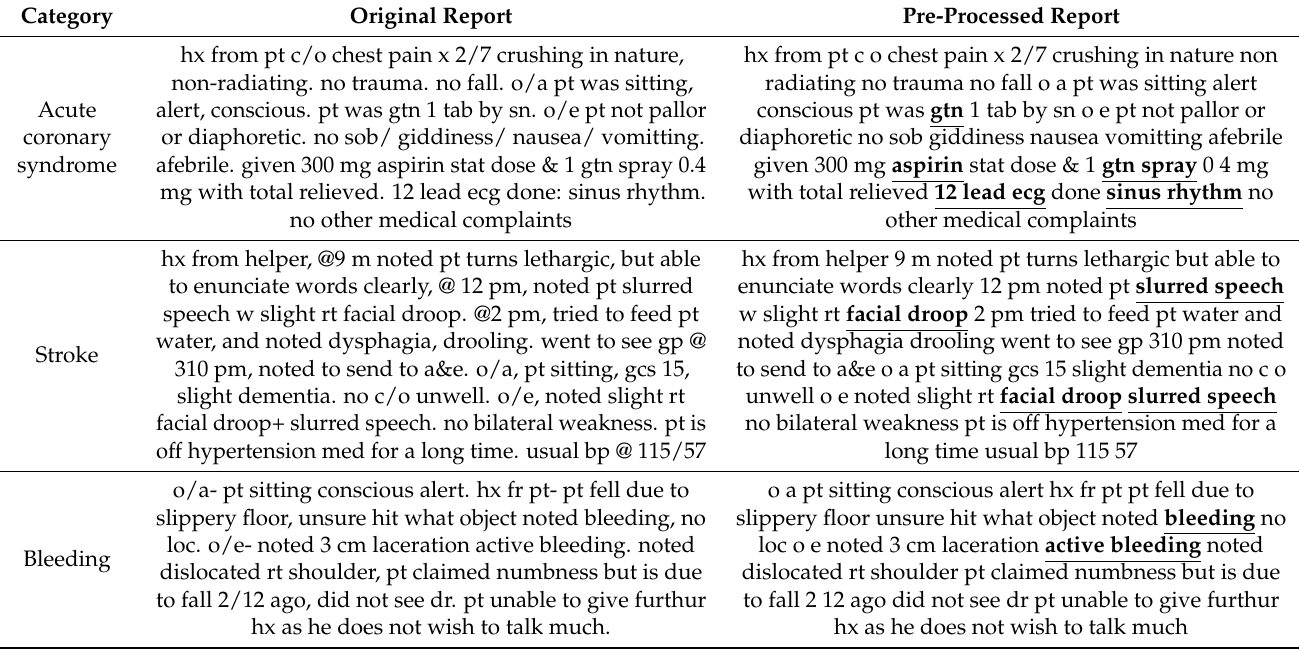
Table 1. Three example text reports under three different case categories before and after pre-processing. The ground truth entities are bolded and